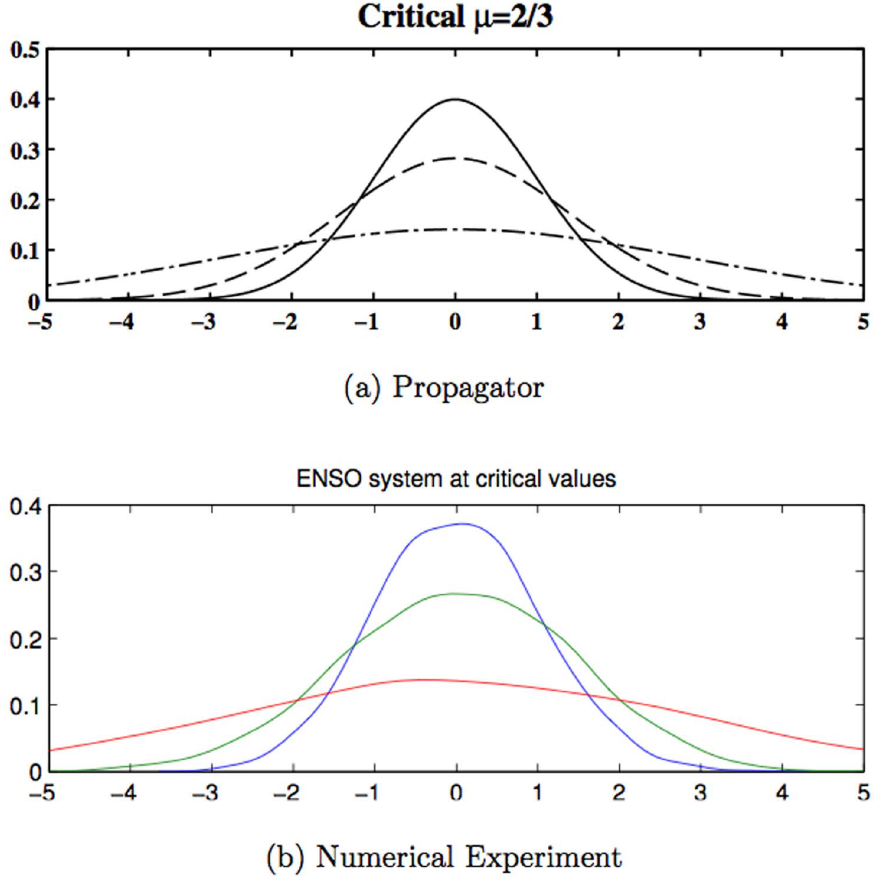
Figure 2. The probability distribution for the subcritical case ( m ~ 2 = 3 ) from the propagator (a) and from 2000 numerical experiment (b). The solid line corresponds to T=1, the dashed line to T=2 and the dot-dashed line to T=8.